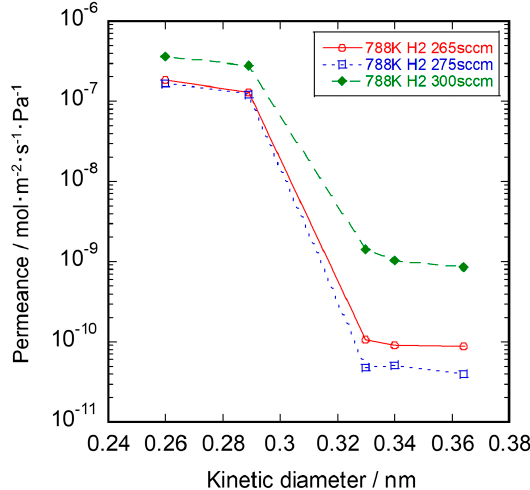
Figure 9. Reaction gas flow rate dependence on single gas permeance of SiC membranes.